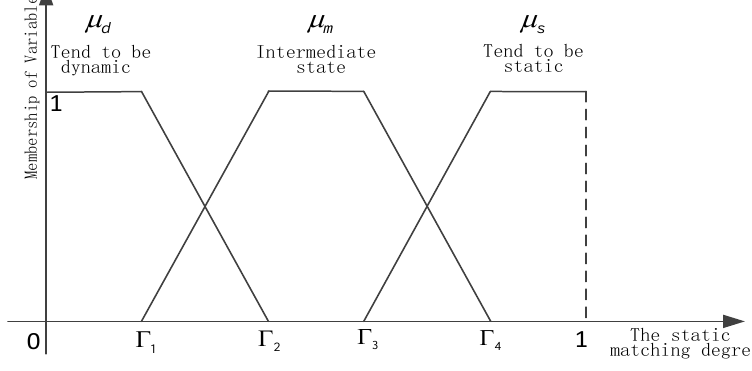
Figure 5. Relational graph of fuzzy variables and static matching